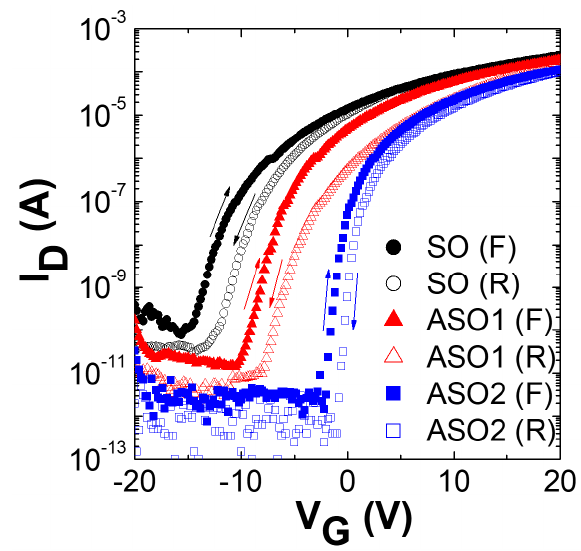
Figure 1. Transfer curves of the SO, ASO1 and ASO2 thin-film transistors (TFTs) containing Al at atom % values of 0, 1.20, and 2.24, which were scanned with forward (F) and reverse (R) bias sweeps (V D = 10.1 V).